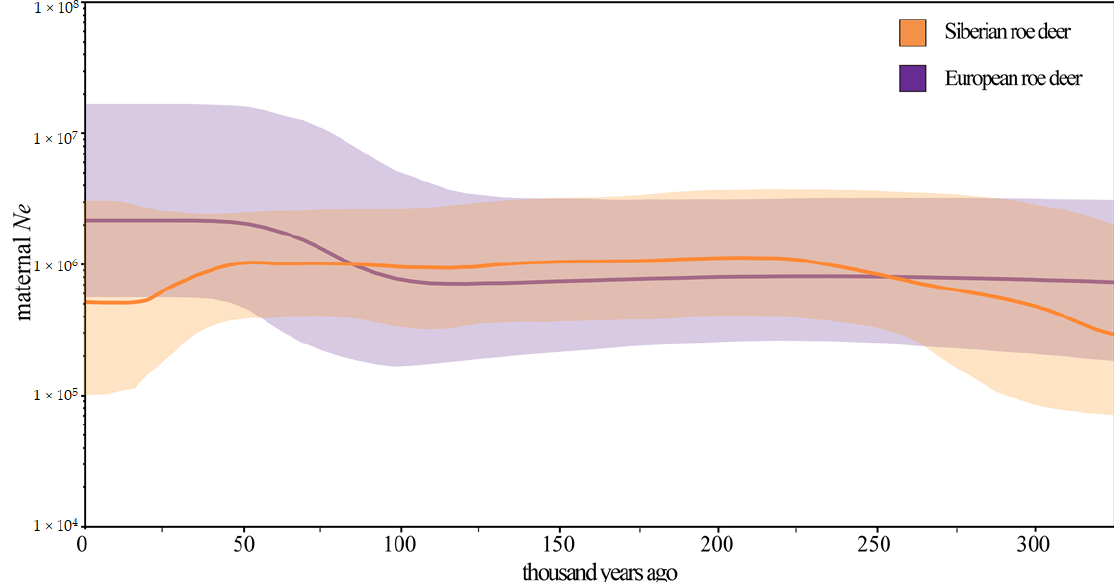
Figure 4. Maternal demographic histories of Siberian and European roe deer reconstructed from mitochondrial genomes. Y -axis represents the female effective population size ( Ne ) while X -axis stands for time. Lines in different colors indicate median female Ne and the corresponding shades show the 95% credibility